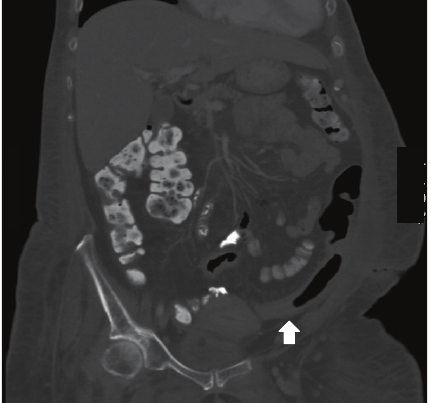
Figure 1: CT of the abdomen/pelvis showing mild wall thickening and an ahaustral appearance of the distal colon with pericolonic fat stranding consistent with